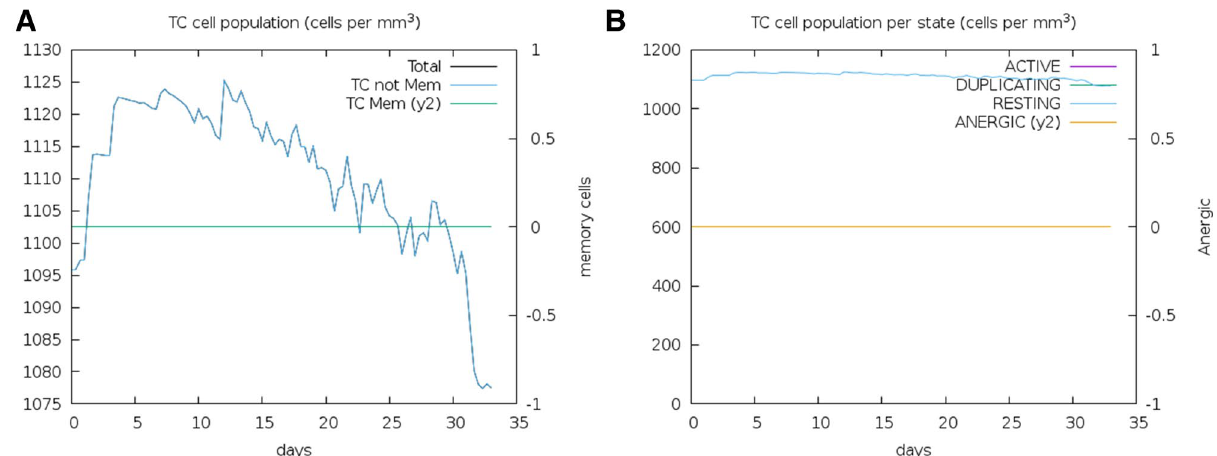
Figure 6. Vaccine constructs in silico immunization analysis. ( A ) CTL response to elicit the Cytotoxic T-cell population for long span. ( B ) Elevated level of Cytotoxic T-cell population in resting state for 30